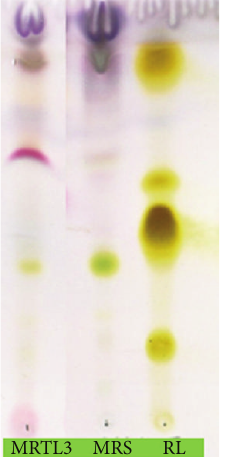
Figure 2: Anisaldehyde staining of BS TLC plate.